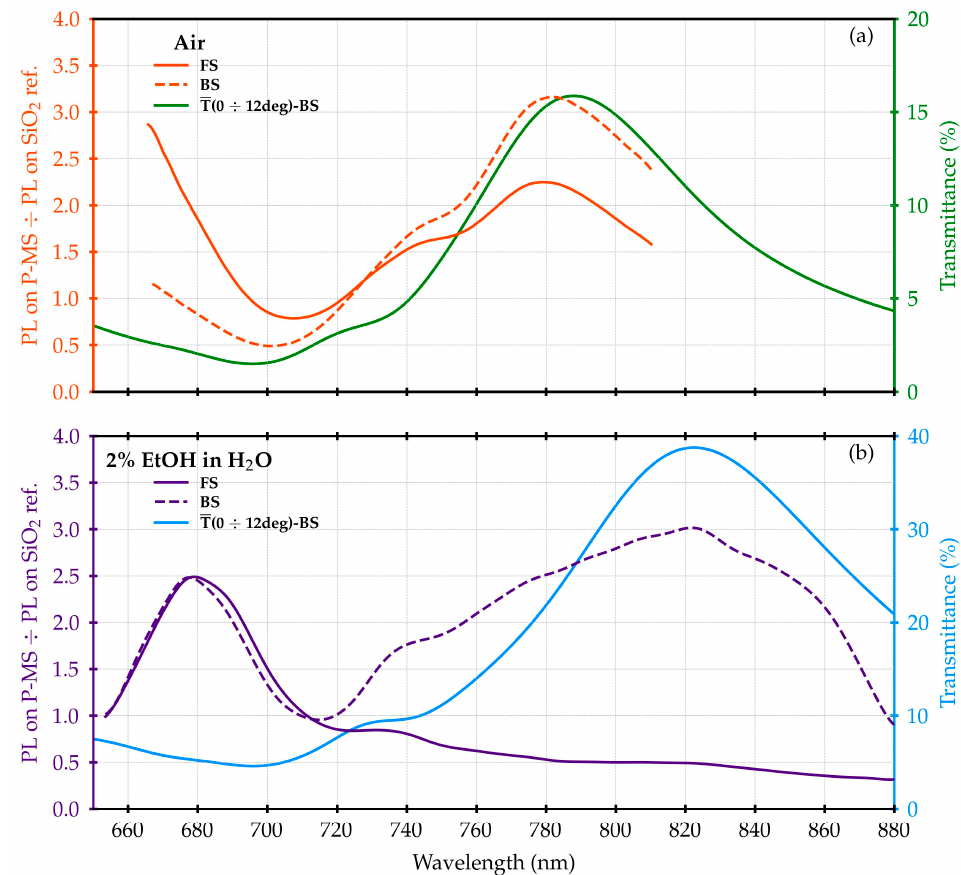
Figure 4. Ratios of the normalized measured fluorescence spectra of ATTO700 dye measured on the plasmonic grating with respect to the SiO 2 reference. The curves reported in panel ( a ) represent the measurements in air for both the FS and BS configurations. In panel ( b ), the corresponding curves in 2% EtOH in water solution are shown. The T signals, mediated over the angles collected by the objective, are also plotted as a comparison.